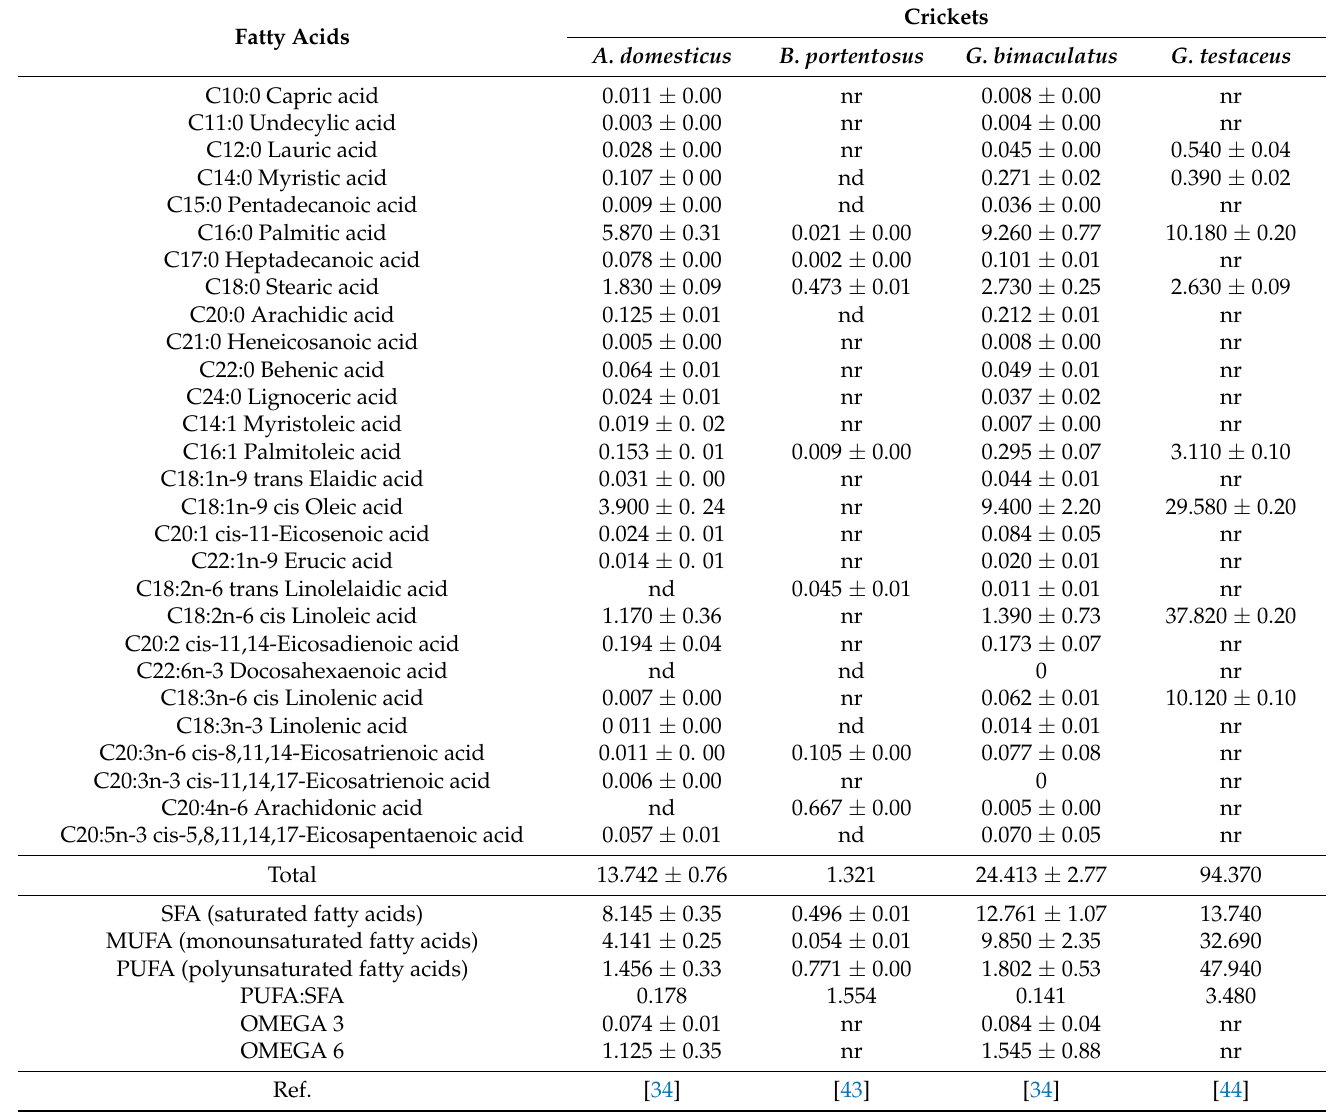
Table 4. Fatty acid profiles (% dry matter) of four non-processed edible